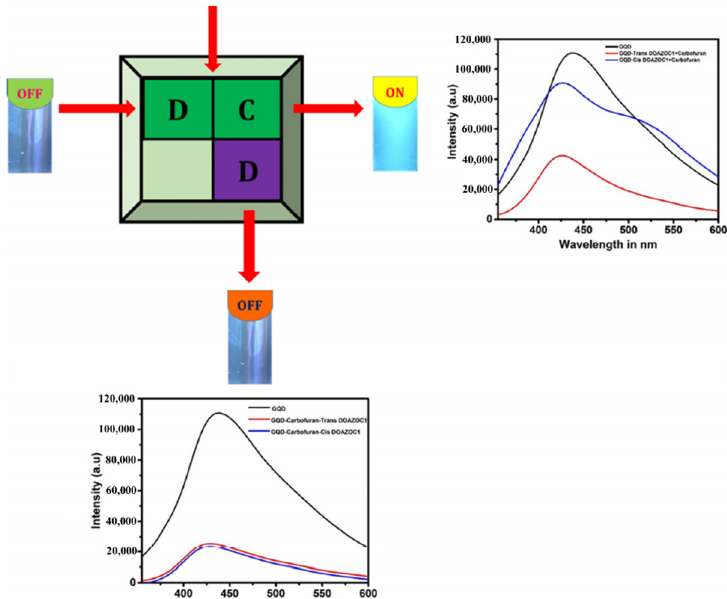
Figure 33. Schematic representation of Molecular Keypad Lock with corresponding fluorescence curves. The letters ‘D’ and ‘C’ represent the chemical inputs DOAZOC1 and Carbofuran, respec- tively. The keys ‘I’ and ‘O’ depict the Fluorescence On (Unlock) and Fluorescence Off (Lock) states, respectively. (Reprinted with permission from [96]; Copyright 2017, John Wiley and Sons).